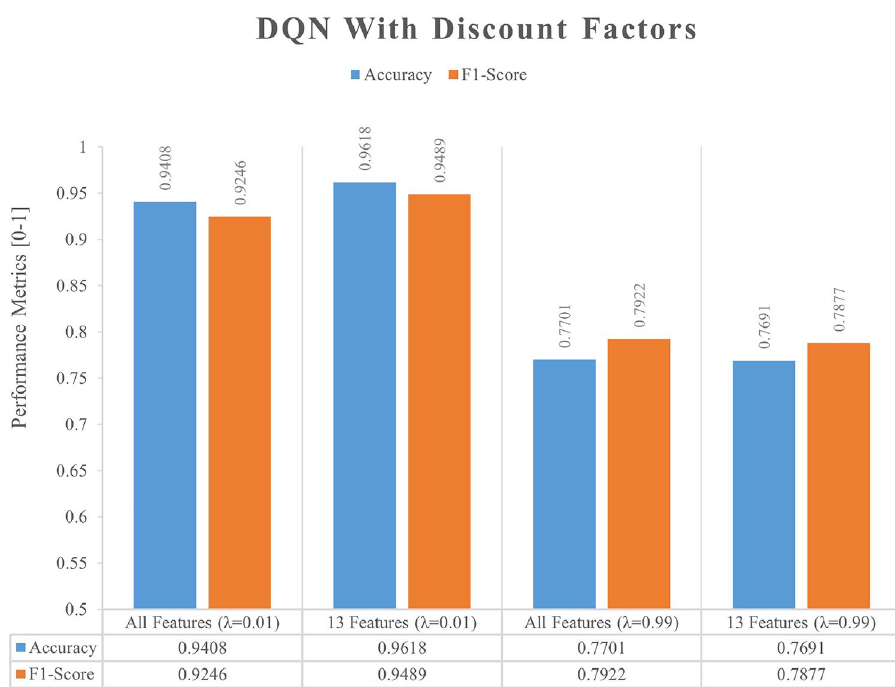
Figure 12. The impact of different discount factors